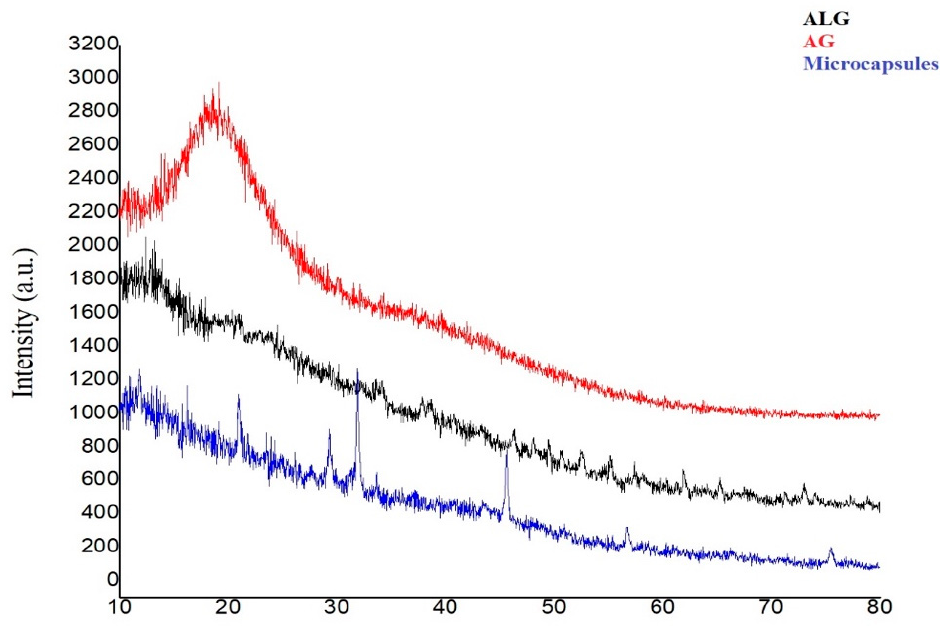
Figure 6. XRD patterns of alginate, Arabic gum and alginate–Arabic gum